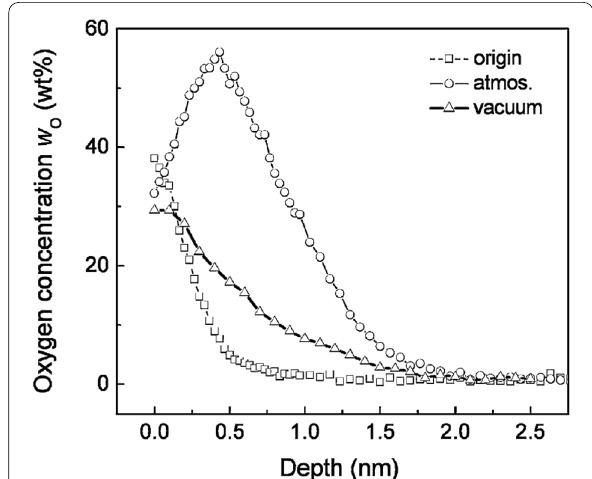
Figure 7 Comparison of atomic concentration of oxygen in wt% measured by a scanning Auger nanoprobe on the original